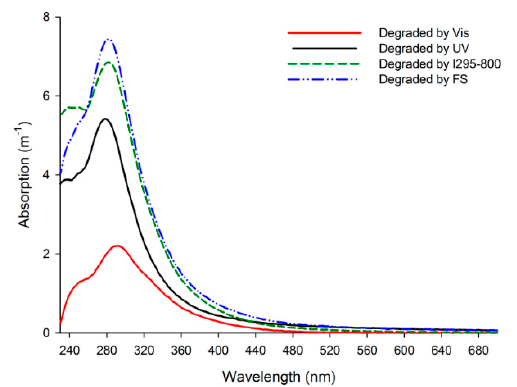
Figure 2. Hypothetical absorption spectra of compounds degraded by different irradiations. For each treatment the spectrum shown is the average spectra of the replicates.